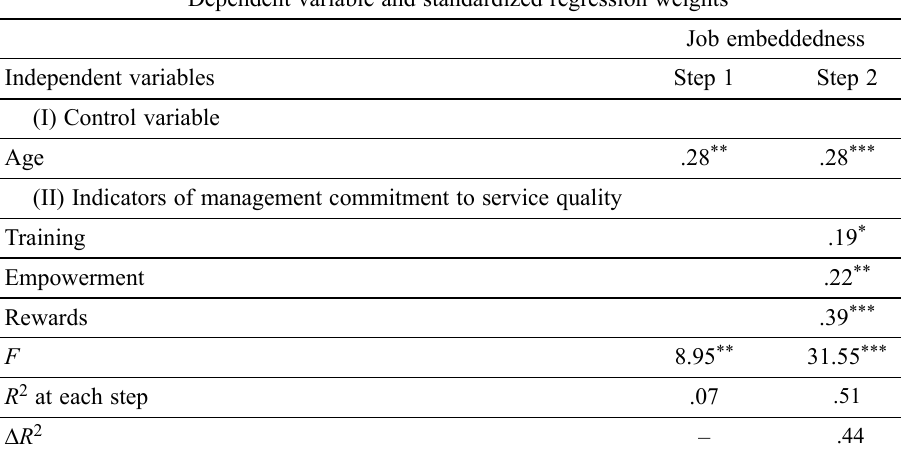
Table 3. Regression results: the effects of training,